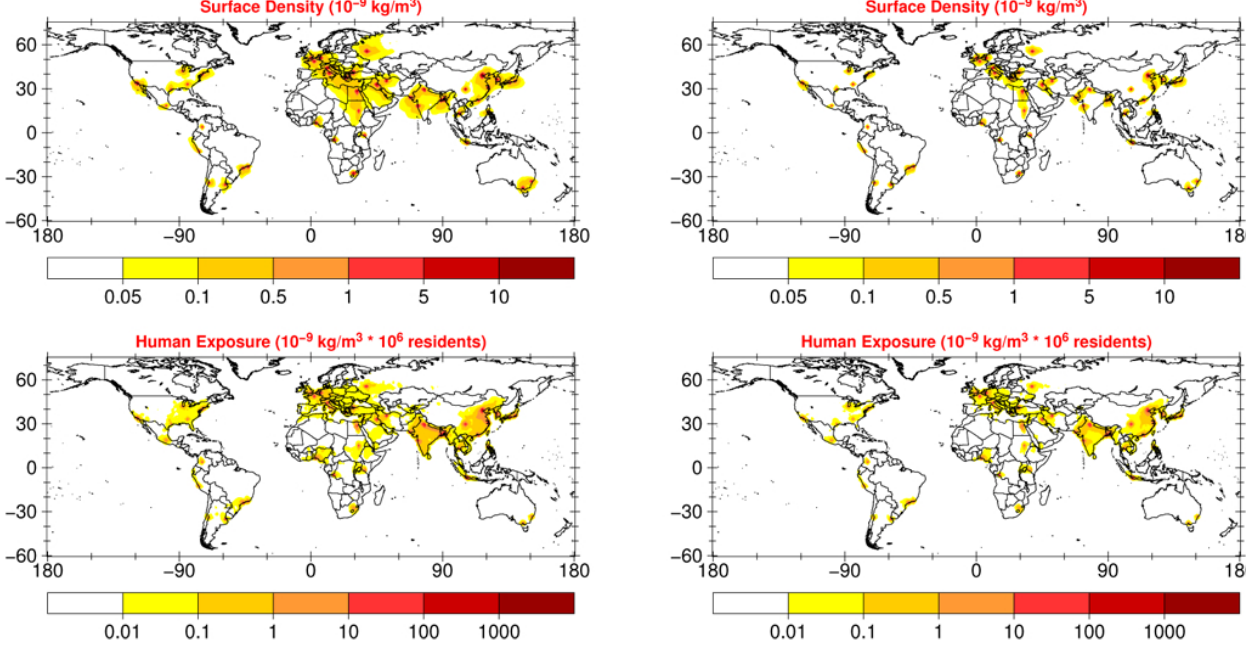
Fig. 8. Sum of all MPC surface densities in 10 − 9 kgm − 3 alone (upper panels) and convolved with the geographical population distribution (lower panels). The left side shows the NS act 1 . 0µm aerosol tracers, the right side the NS act 10 . 0µm aerosol